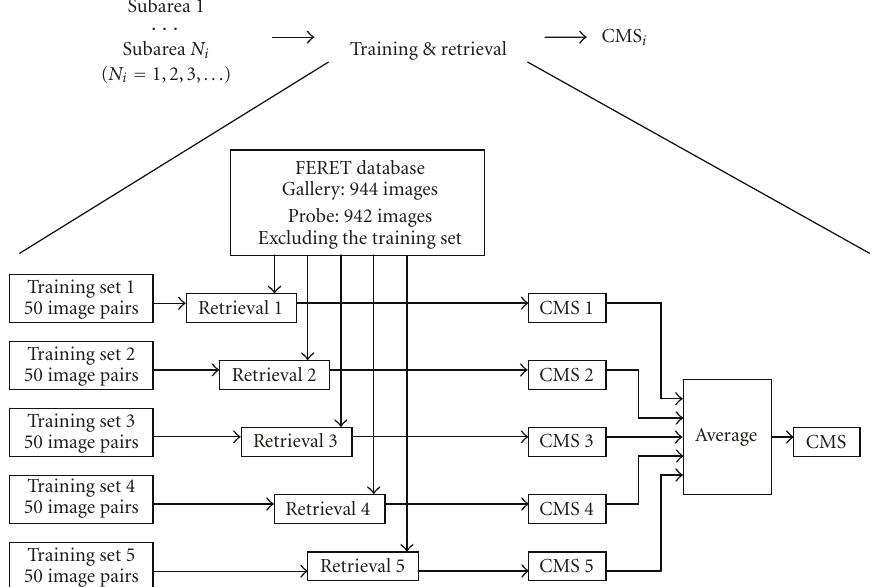
Figure 7: Training process: the optimal parameter set from five training sets is utilized separately, which give five CMS scores. The overall performance of given subarea will be evaluated as the average of above five CMS scores. 50 pairs of images selected from FA and FB are used as the training set. The remaining 944 images in FA and 942 images in FB are used together as the testing set. Such “training +testing” process has been repeated five times. Since the training sets for each time are di ff erent from each other; therefore, the testing sets for each time are also di ff erent from each other. However, the number of di ff erent image pairs between any two tests is 50 out of 942.